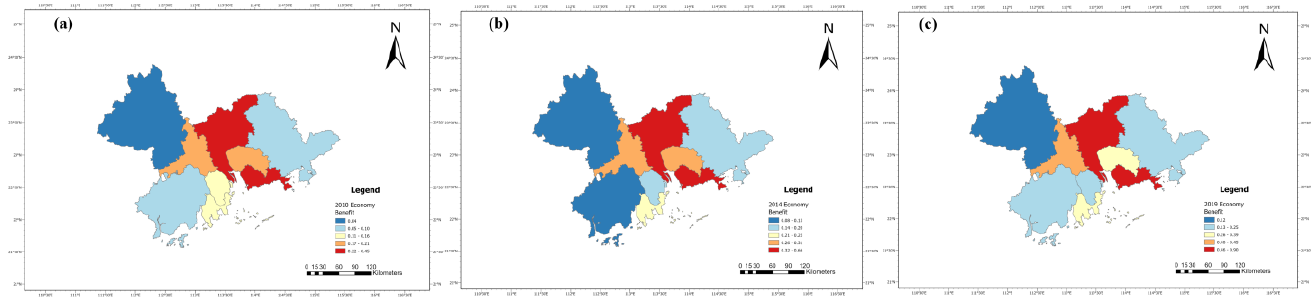
Figure 7. The benefit index of the economic development system in nine cities in the PRD.